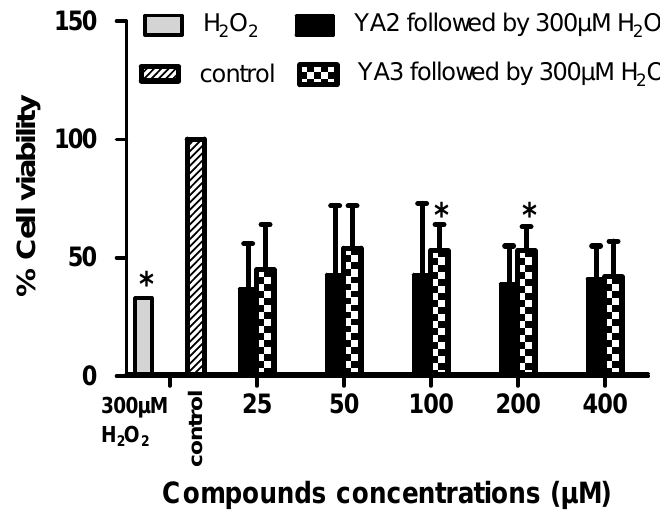
Figure 5. Neuroprotective activity of synthetic spiroisoxazoline type compounds. Differentiated SH-SY5Y cells were treated with 300 µM hydrogen peroxide in the presence or absence